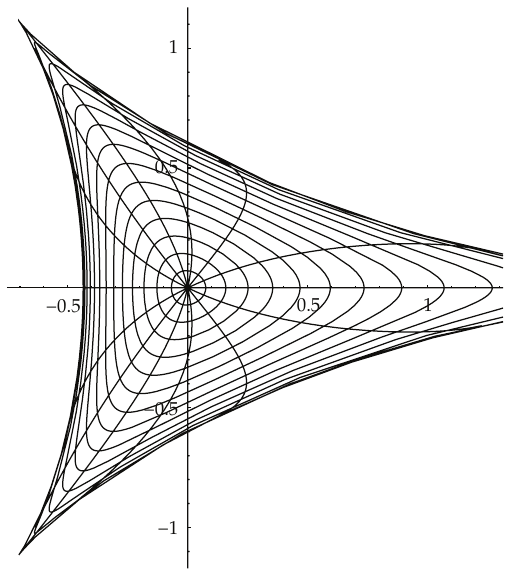
Figure 4: The image of f (cid:3) z (cid:4) (cid:5) −